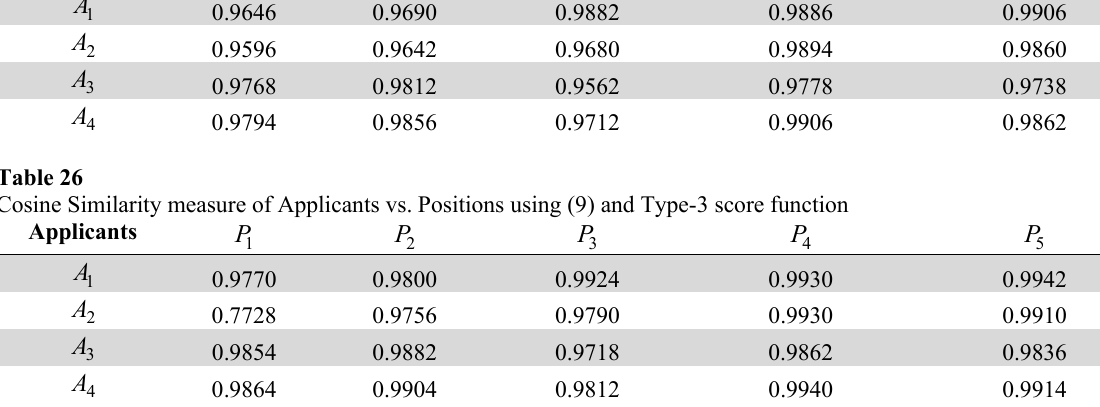
Cosine Similarity measure of Applicants vs. Positions using (9) and Type-2 score function Applicants